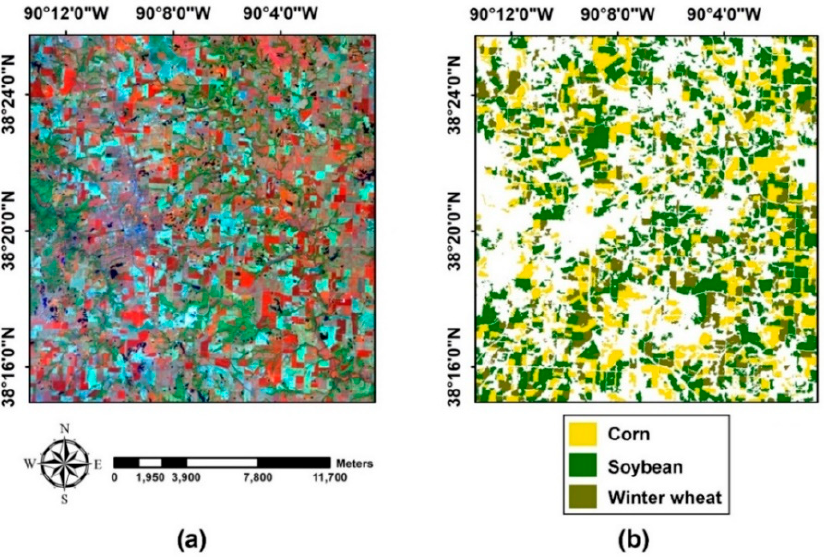
Figure 2. Data sets used for crop classification in Illinois: ( a ) false color composite (near-infrared (NIR)–short-wave infrared (SWIR)–Red) of Landsat-8 Operational Land Imager (OLI) imagery on 8 April 2017; ( b ) cropland data layers (CDL) data.